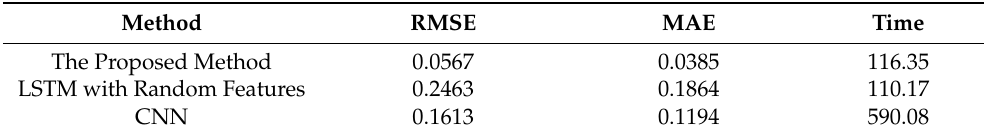
Table 7. Comparison of different prediction models.